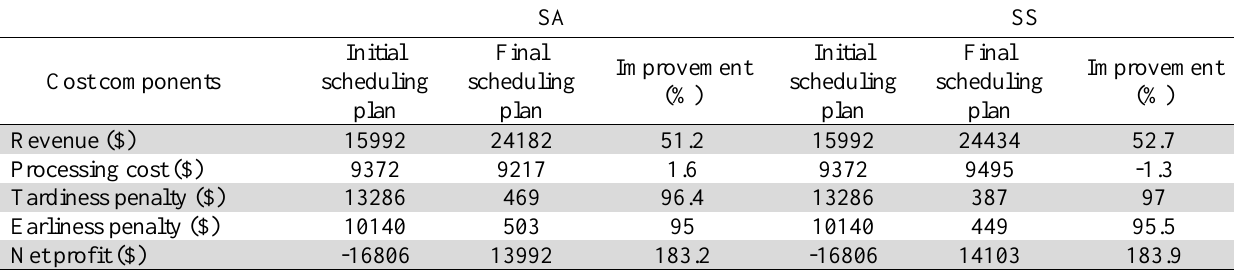
Summary of Results for the 80-job Instance